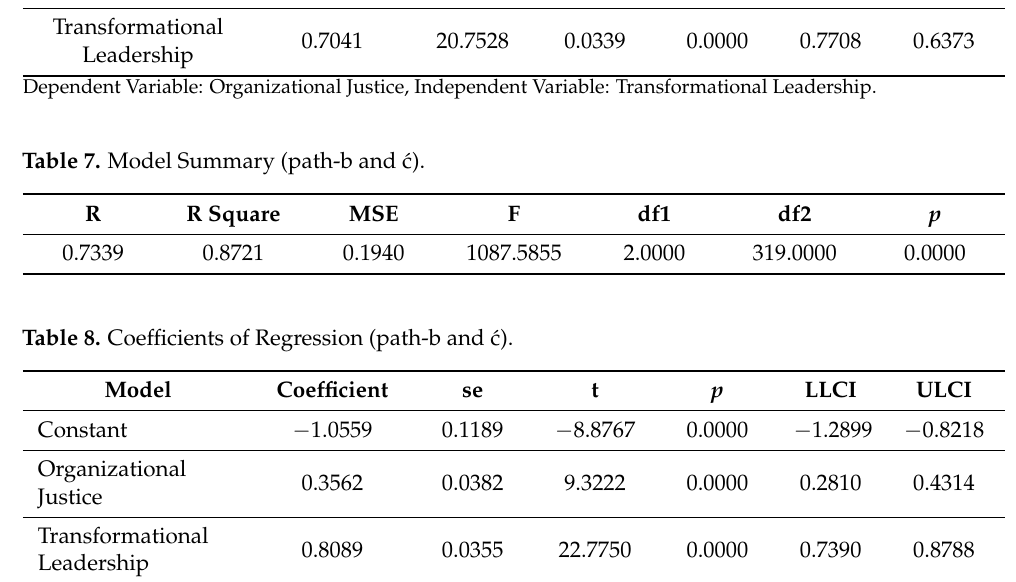
ble: Academics ’ Performance.